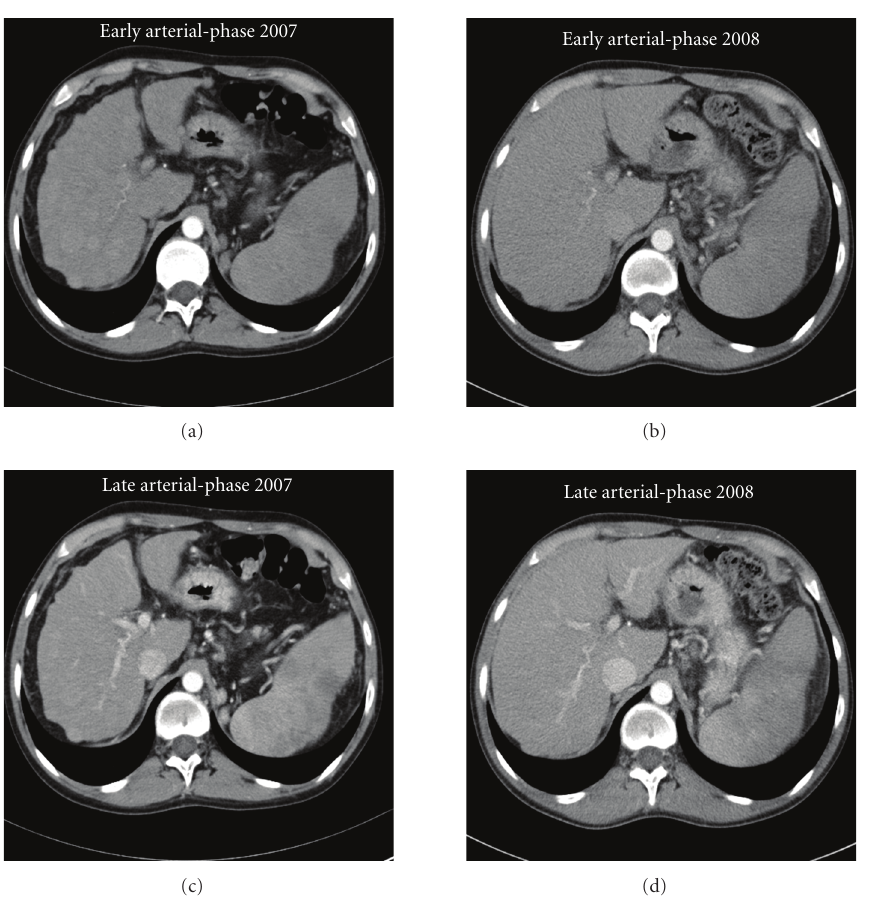
Figure 1: Arterial-phase axial CT images following the administration of contrast medium demonstrate multiple hyperdense nodules at the early arterial phase. Nodules are not visible on unenhanced